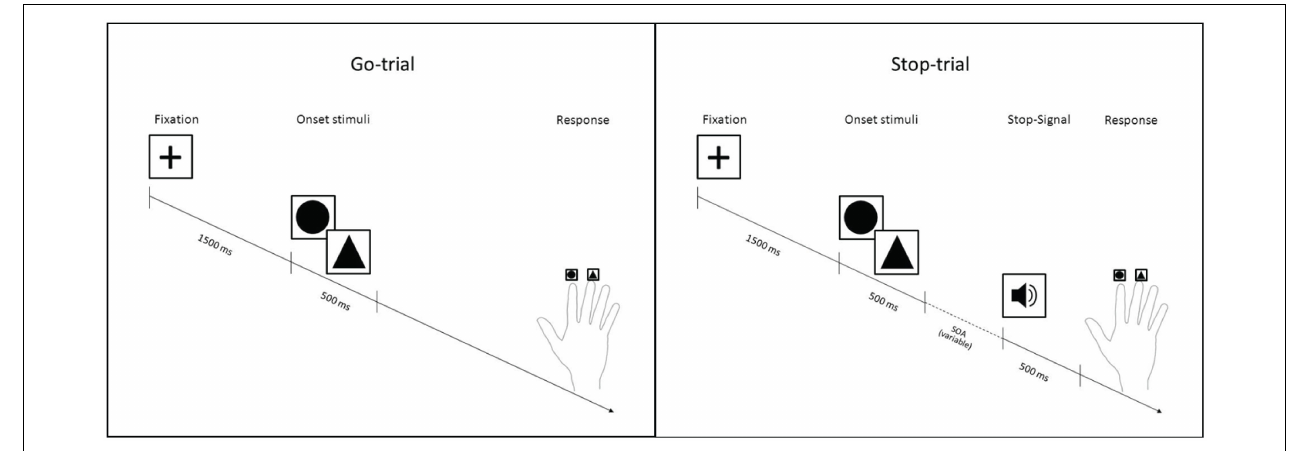
FIGURE 1 | Stop-signal